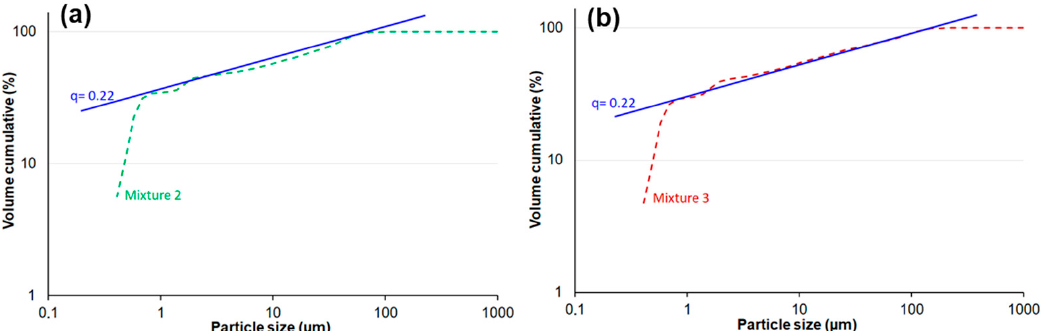
Figure 2. Graphical illustration of the PSD optimization according Andreasen coefficient of 0.22. ( a ) Composition of the CZM-2A (mixture 2); ( b ) Composition of the CZM-4A (mixture 3).